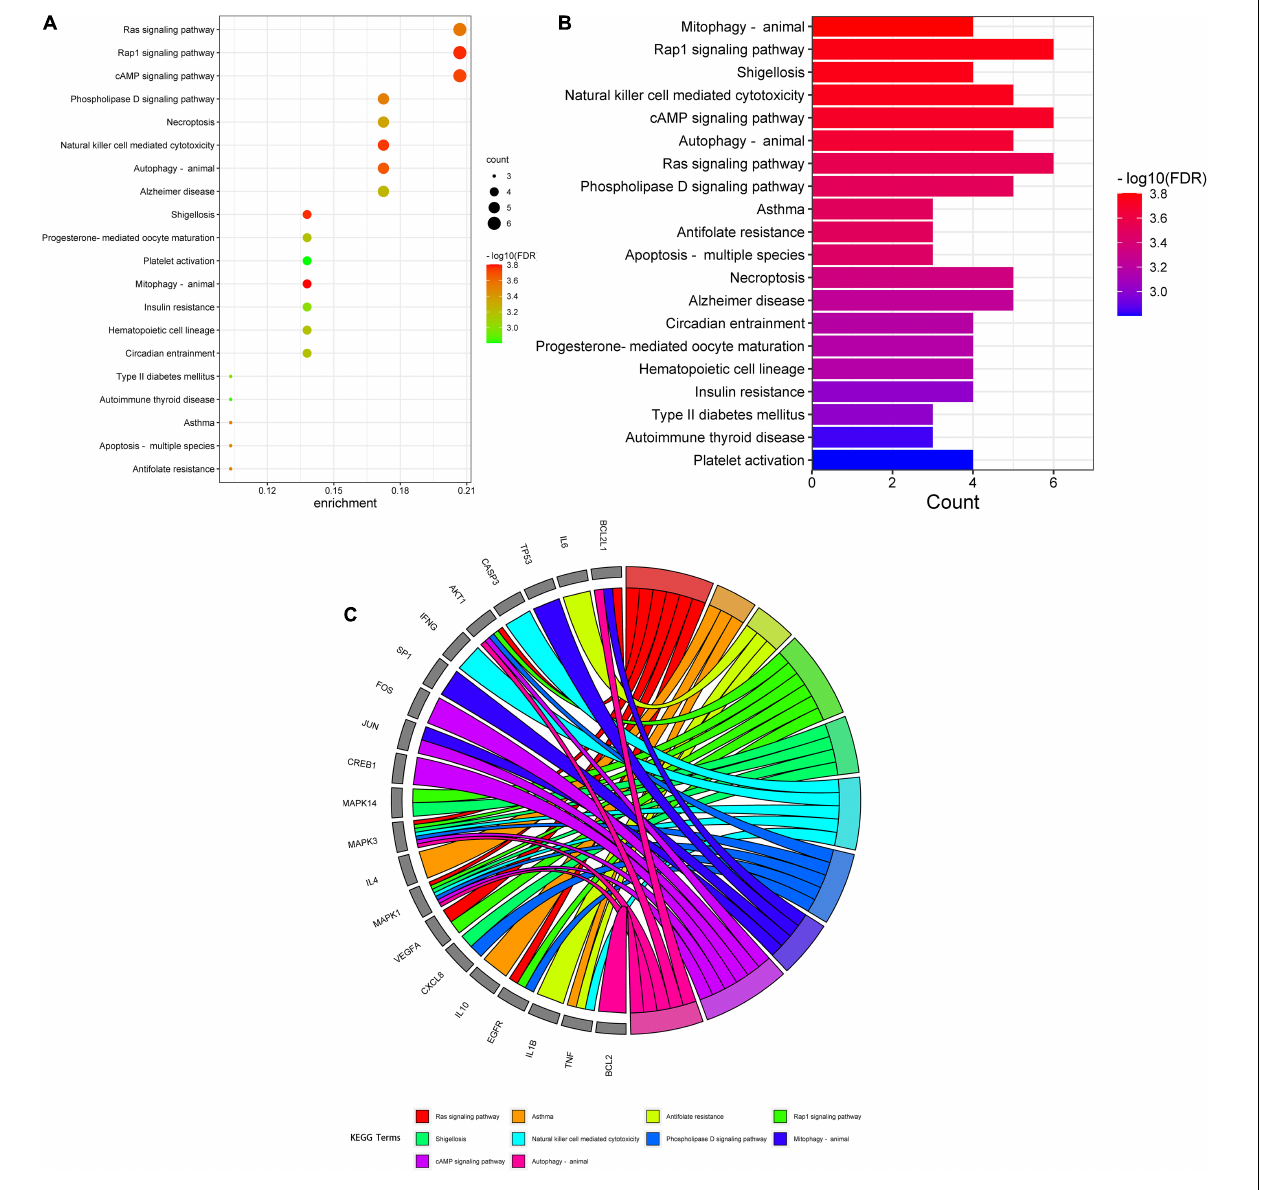
FIGURE 3 | Gene ontology enrichment analysis findings in VA against As-linked dermatitis, as revealed in bubble chart (A) , bar chart (B) , circle chart (C) .